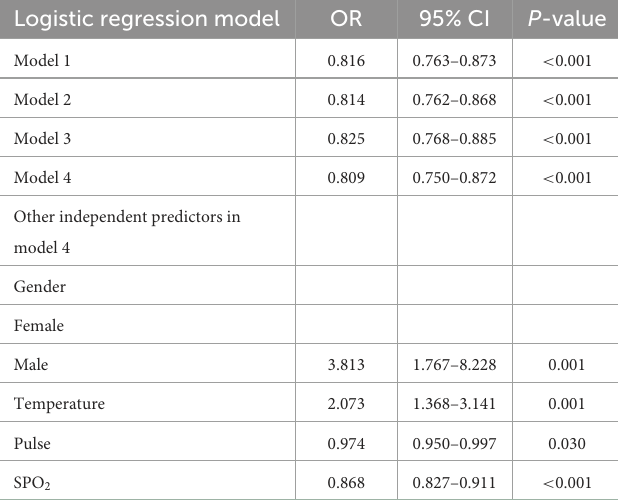
TABLE 3 Logistic regression models for Barthel Index as a predictor for the prognosis of COVID-19 patients. Logistic regression